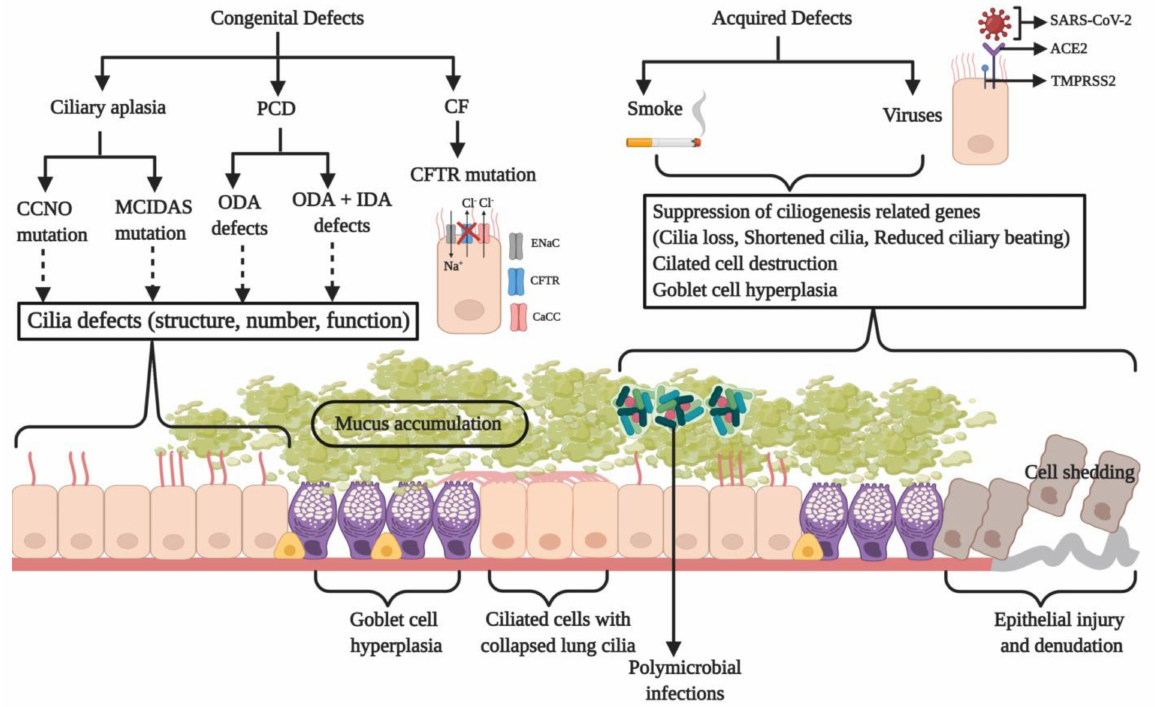
Figure 3. A schematic illustration of the genetic or acquired defects in the respiratory MCC apparatus that impair the clearance mechanism of the respiratory airways and lead to a diseased state. Defective cilia structure, function, or cilia loss may occur due to genetic (primary ciliary dyskinesia (PCD), ciliary aplasia), acquired (smoke), or viral factors, and they could manifest in the form of diseases like chronic obstructive pulmonary disease (COPD), asthma, and PCD where an inadequate mucus expulsion causes its build-up in the airways. During cystic fibrosis, a faulty cystic fibrosis transmembrane conductance regulator (CFTR) and goblet cell hyperplasia result in the reduction of periciliary layer (PCL) volume and mucus hyper-secretion, respectively. This causes the cilia to collapse, thereby resulting in inefficient MCC. The accumulated mucus promotes microbial colonization and the exacerbation of the disease. Microbial infections aggravate the condition and eventually damage the epithelial lining as a result of ciliated cell shedding. Illustration made using